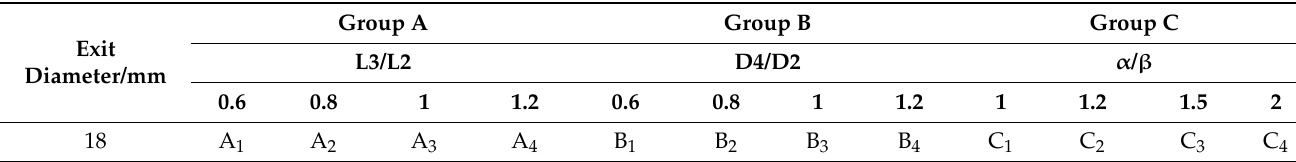
Table 1. The parameters of the dimensionless